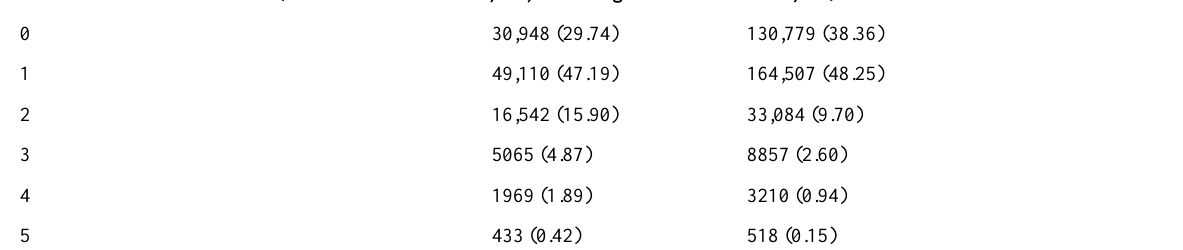
Between-group differences, P